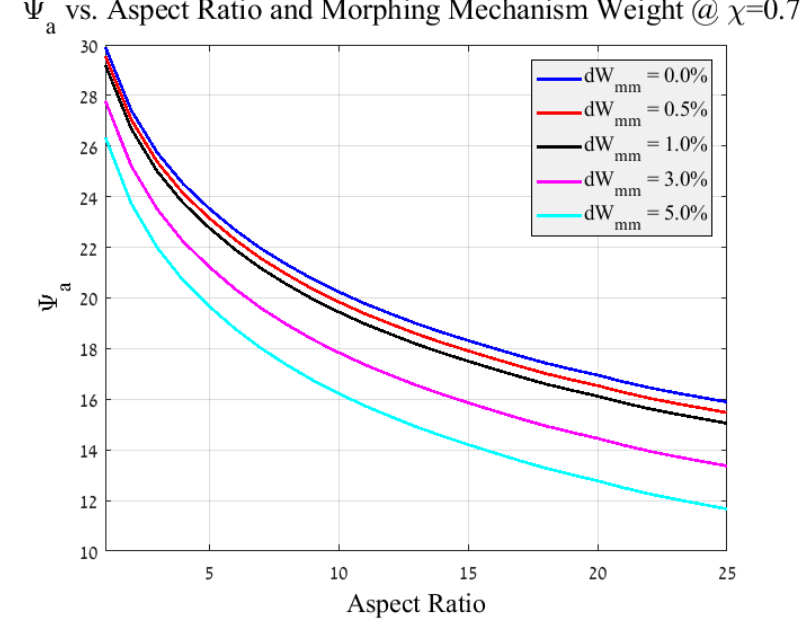
Figure 10. Ψ a vs. aspect ratio and several morphing mechanism weight at flight scenario χ = 0.7.